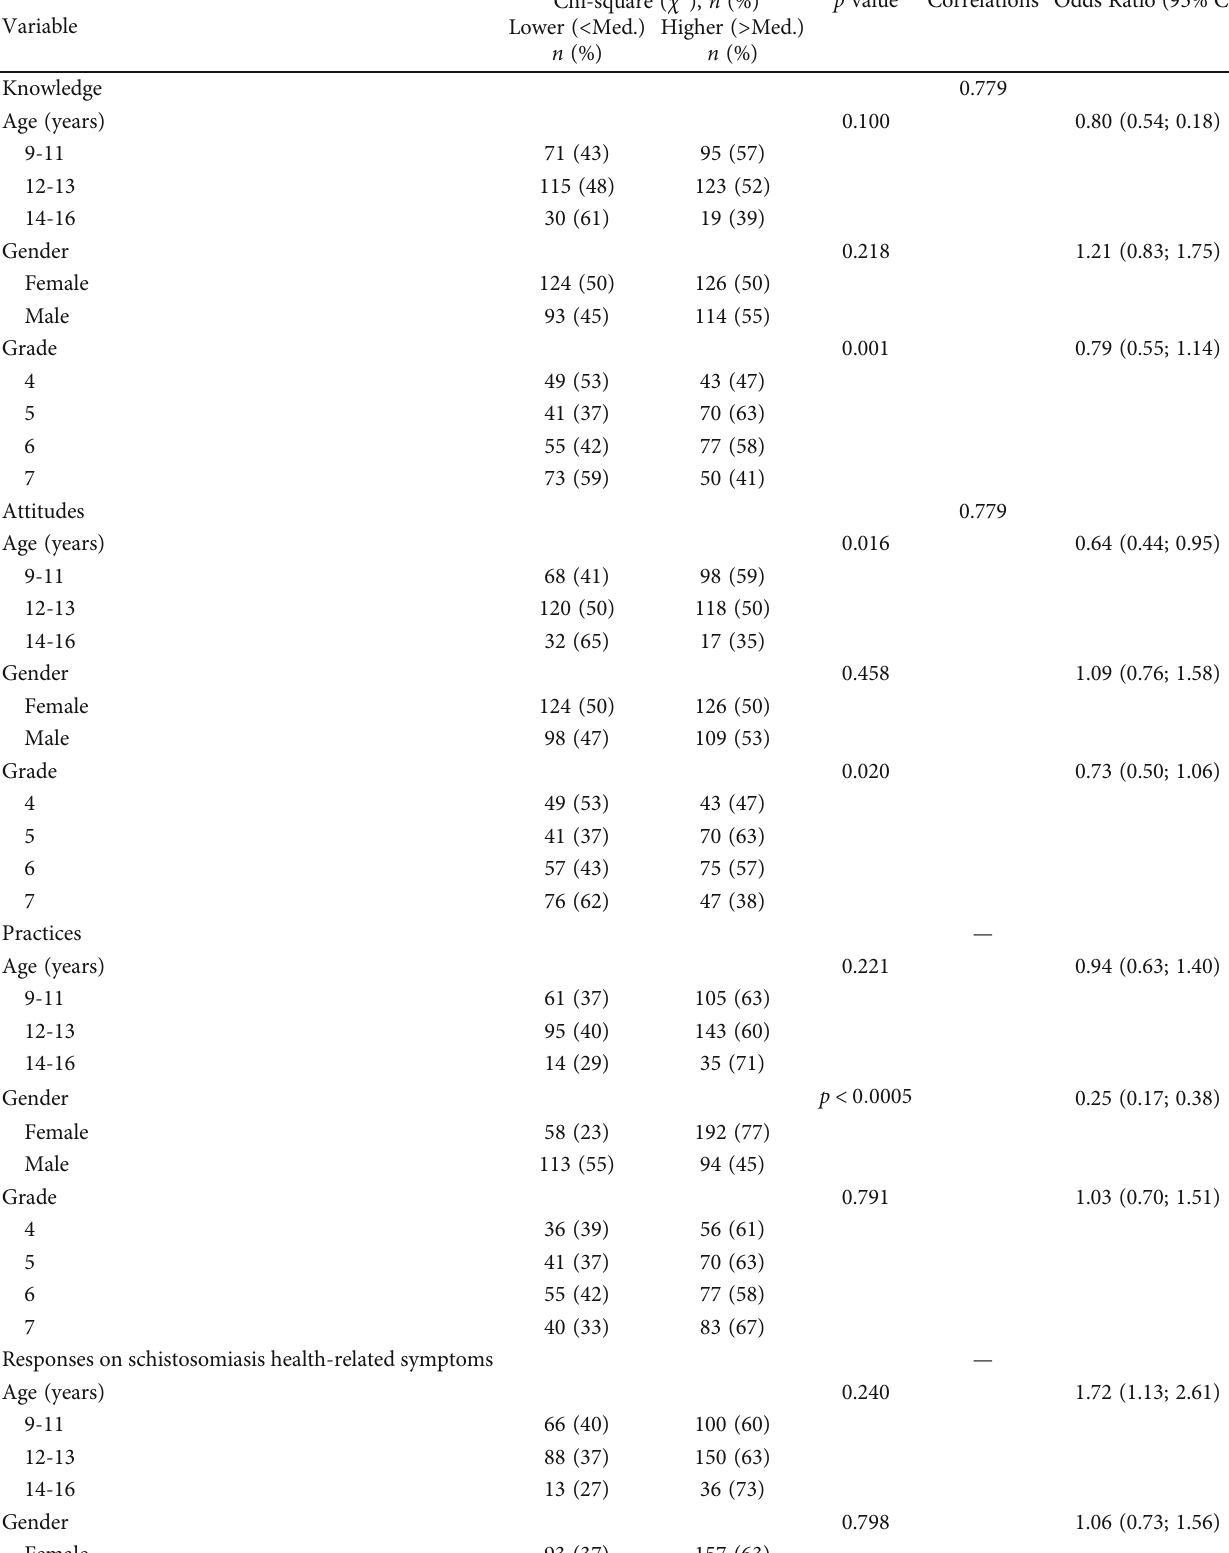
Table 7: Multivariate analysis of knowledge, attitudes, practices, and health factors relating to schistosomiasis among the study participants ( n = 458